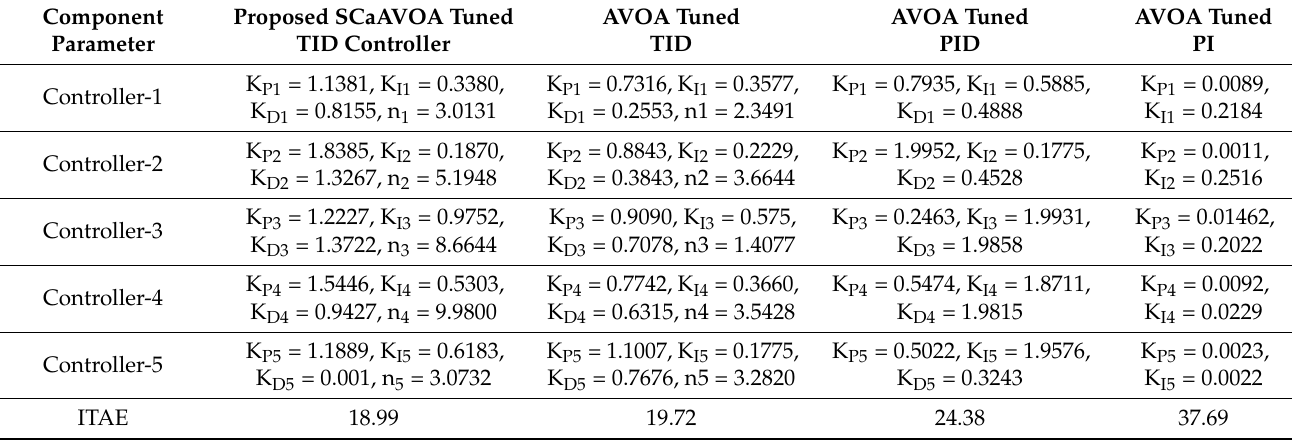
Table 6. Controller parameters for the five-area, ten-unit hybrid power